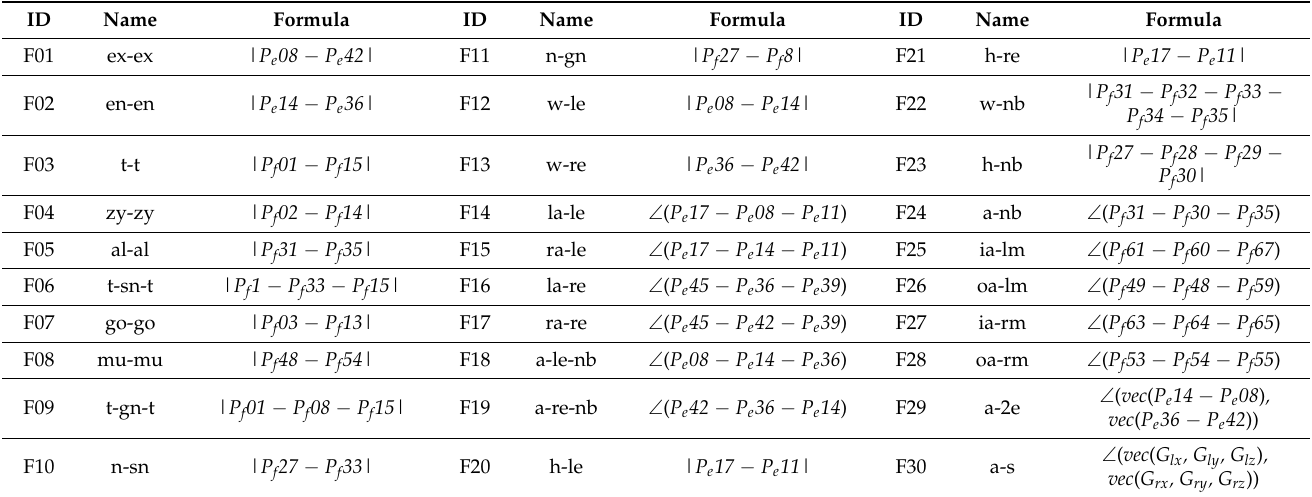
Table 2. Geometric features of facial